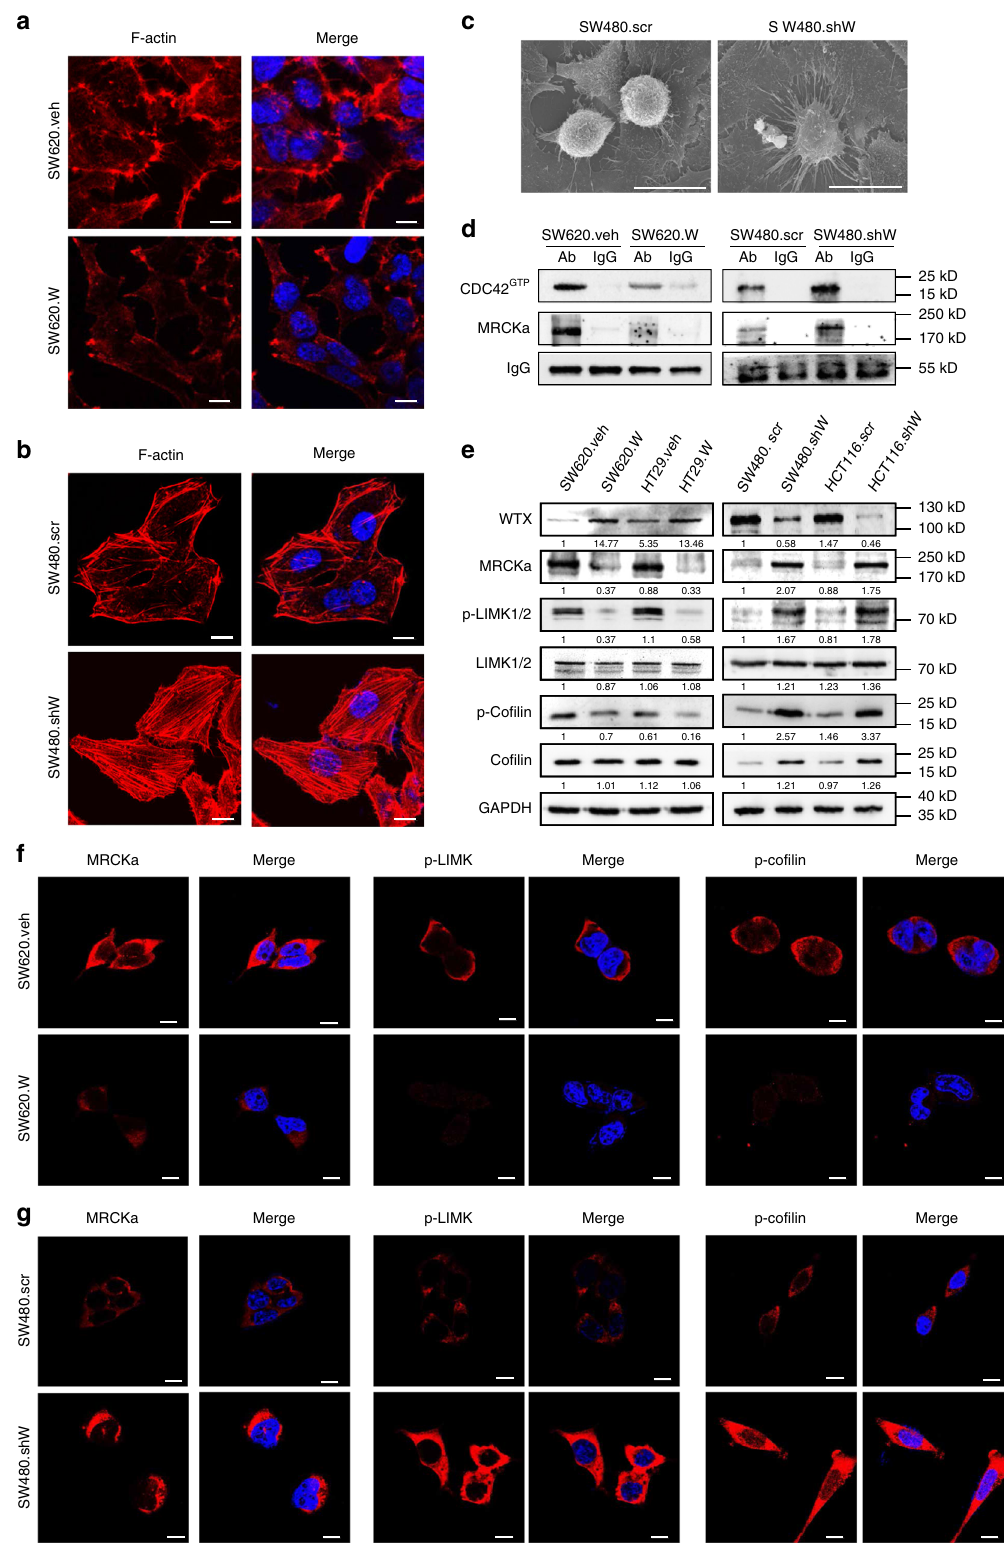
Fig. 4 WTX stabilizes F-actin through inhibiting the CDC42 signaling pathway. a IF staining analyzes the expression and location of F-actin in control and WTX-overexpressing cells. b IF staining analyzes the expression and location of F-actin in control and WTX knockdown cells. c Scanning Electron Microscopy (SEM) analyzes the cell morphology in indicated cells. d CO-IP analyzes the interactions between MRCK α and CDC42 GTP in indicated cells. e IB analyzes the CDC42 pathway proteins in indicated cells. f , g IF staining analyzes the expression and location of MRCKa, p-LIMK1/2, and p-Co fi lin in control, WTX overexpression ( f ) and knockdown ( g ) cells. Scale bars, 10 μ